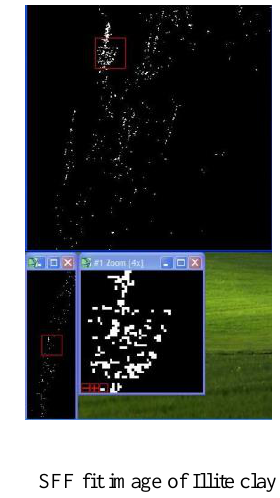
Fig 2 SFF fit image of Illite clay mineral.